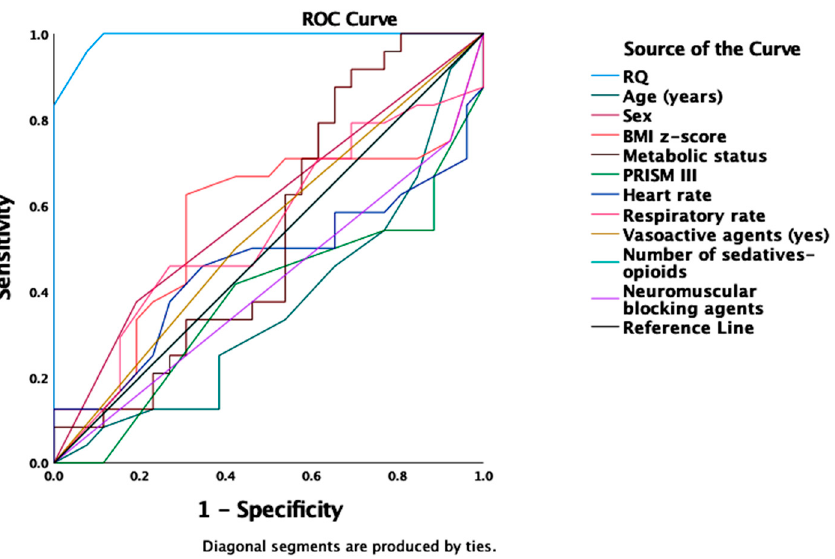
Figure 4. An Area Under the Receiver Operating Characteristic Curve (AUROC) for predicting REE VCO2 RQ 0.89 underestimating REE IC for more than − 10%. Among various metabolic, demographic, and clinical variables, only the measured RQ was a strong predictor of REE VCO2 RQ 0.89 inaccuracy (AUROC 0.991 (95%CI 0.975–1.0), p < 0.001). Abbreviations: REE VCO2 RQ 0.89 = Resting Energy Expenditure (REE) based on volumetric carbon dioxide production (VCO 2 ) measurements (REE VCO2 ) using assumed RQ of 0.89; REE IC = REE measured by indirect calorimetry (IC). Regarding the smaller proportion of +10% inaccuracy, measured RQ (AUROC 0.804 (95%CI 0.643–0.966), p = 0.013) and a high PRISM III score (AUROC 0.819 (95%CI 0.646– 0.992), p = 0.009) were strong predictors of REE VCO2 overestimating REE IC for more than +10% (Table 5). Table 5. Area Under the Curve for variables predicting REE VCO2 RQ 0.89 inaccuracy by overestimating REE IC for more than +10%. Asymptotic 95% Confidence Interval Test Result Variable(s)